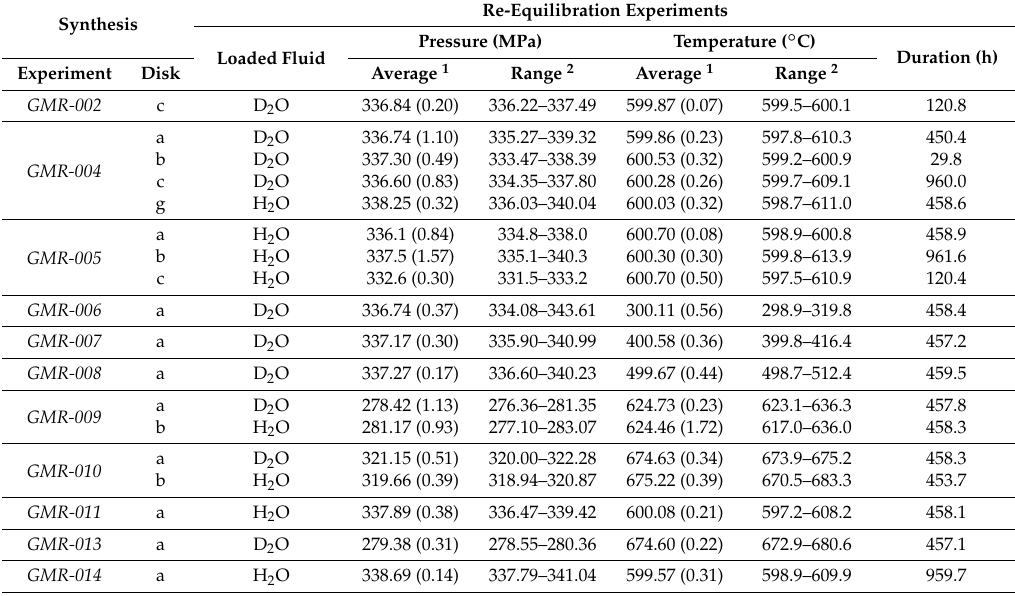
Table 3. Conditions of re-equilibration experiments.